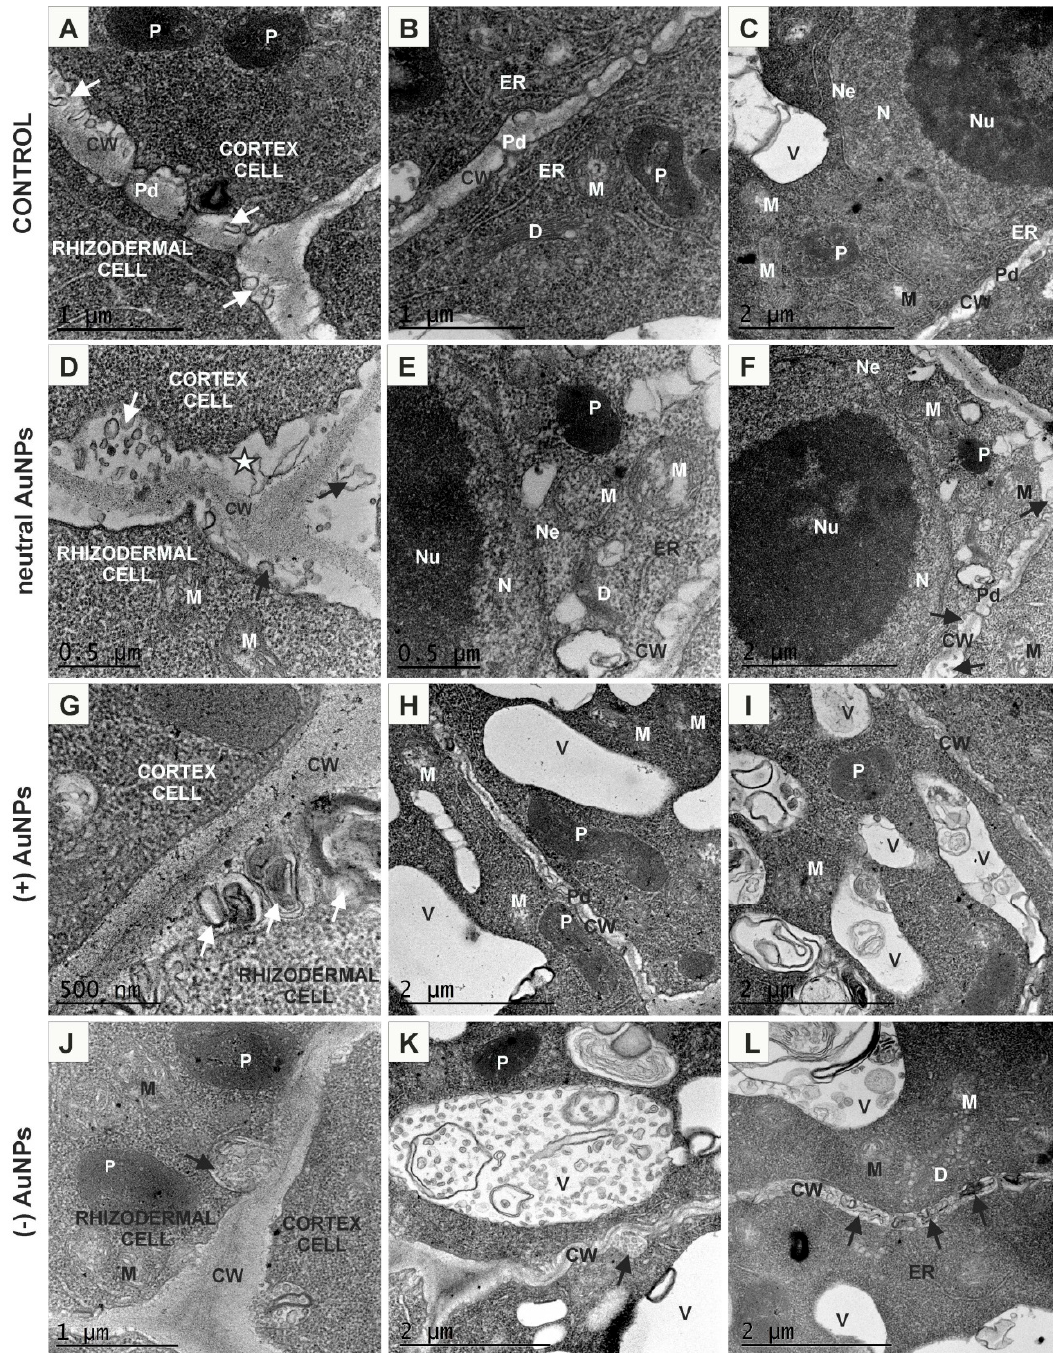
Figure 4. Ultrastructure of cortical cells from the control roots ( A – C ); treated with neutral AuNPs ( D – F ), (+) AuNPs ( G – I ) and ( − ) AuNPs ( J – L ). CW—cell wall; D—dictyosome; ER—endoplasmic reticulum; M—mitochondria; N—nucleus; Ne—nuclear envelope; Nu—nucleolus; P—plastid; Pd—plasmodesmata; V—vacuole; Ve—vesicle; arrows—paramural bodies; asterisk—periplasmic space.